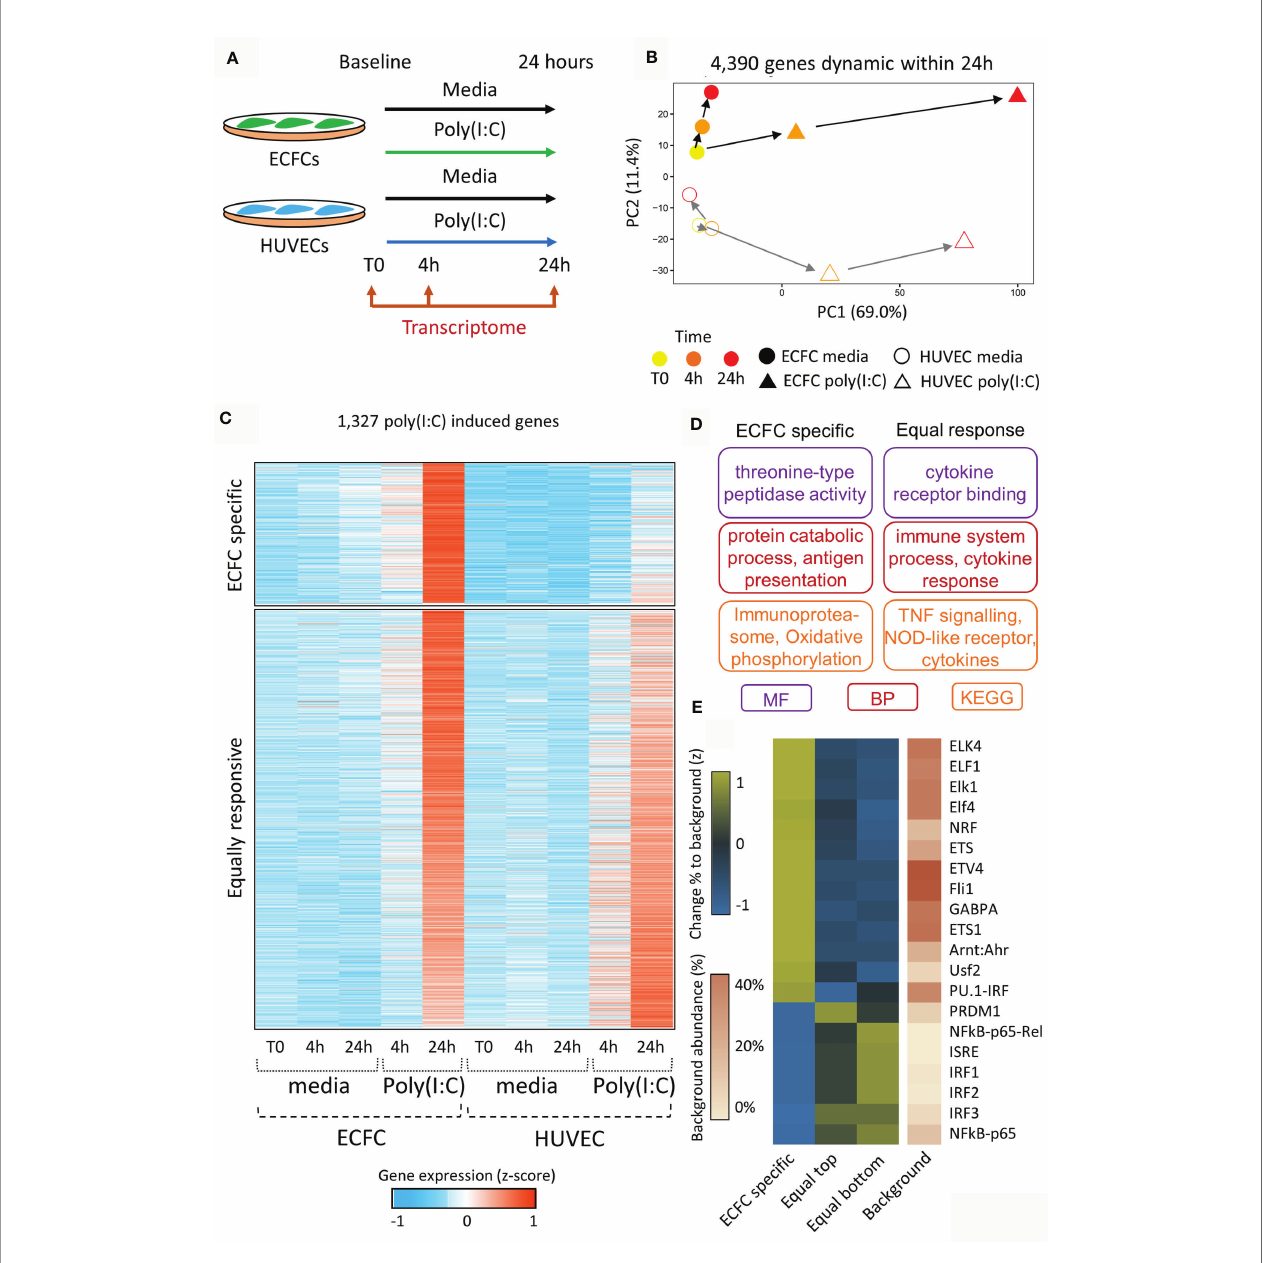
FIGURE 2 | Transcriptional reprogramming of ECFCs and HUVECs in response to viral mimic Poly(I:C). (A) Experimental model. (B) PCA plot of transcriptomic changes that occur 4 hours and 24 hours following Poly(I:C) exposure. PC1 shows the response to Poly(I:C), which peaks at 24h, while PC2 represents the difference between ECFCs and HUVECs. (C) Heatmap showing genes upregulated by Poly(I:C) at 24h. A subset of genes is only induced in ECFCs, while the majority are equally induced in both cell types. (D) Gene ontology terms associated with ECFC-speci fi c and equally induced genes. (E) Heatmap showing enrichment of transcription factor motifs at promoters of ECFC-speci fi c and equally induced